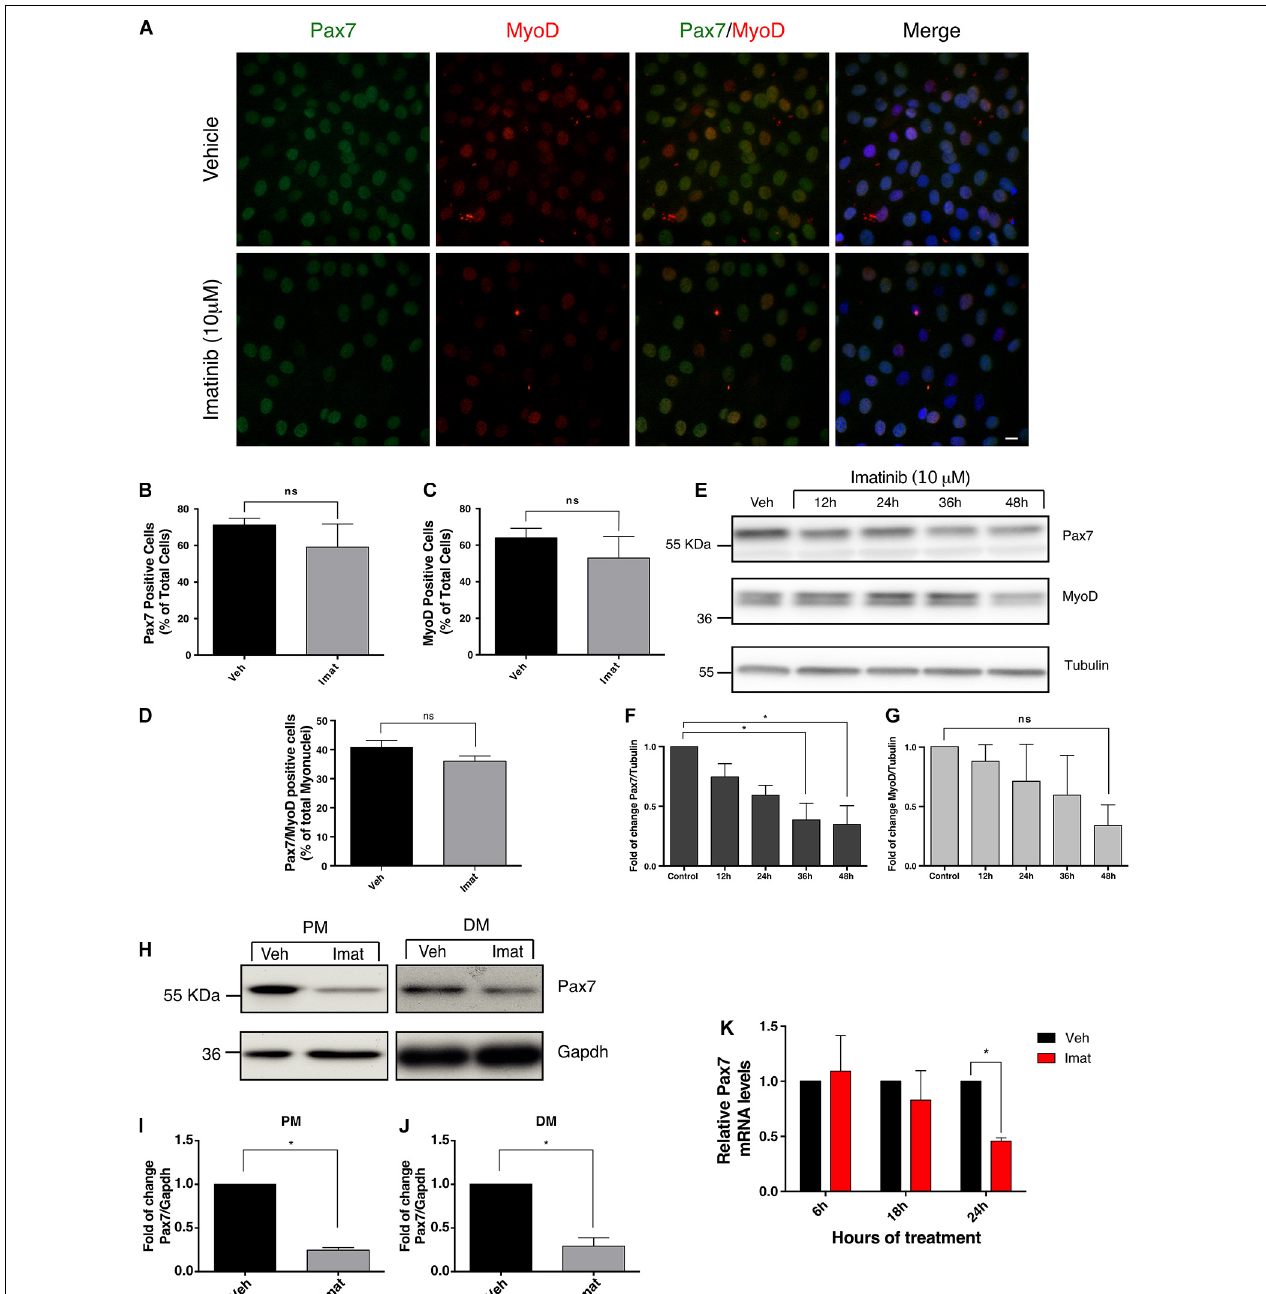
FIGURE 3 | c-Abl inhibition decreases Pax7 protein and mRNA levels. (A) Imatinib treatment does not decrease the number of Pax7 or MyoD positive cells. C2C12 cells were maintained in PM and treated with vehicle (Veh) or 10 µ M Imatinib (Imat) for 48 h. Then cells were fixed, and IF for Pax7 (green) and MyoD (red) was performed. Nuclei were stained with Hoechst 33342 (blue). Scale bar: 10 µ m. (B) Quantification of Pax7 positive cells from (A) . Veh mean: 71.11 ± 3.77%; Imat mean: 59.16 ± 12.62%. (C) Quantification of MyoD positive cells from (A) . Veh mean: 64.05 ± 5.16; Imat mean: 52.97 ± 11.70%. (D) Quantification of Pax7/MyoD double positive cells from (A) . Veh mean: 40.79 ± 2.38%; Imat mean: 36.06 ± 1.75% ( n = 4, P -value > 0.05, Mann–Whitney test, ns, not significant). (E) Imatinib induces a time-dependent drop of Pax7 protein. C2C12 cells were maintained in PM as specified and treated with 10 µ M Imatinib every 24 h. Cells were lysed, and WB was performed to determine levels of Pax7 and MyoD. Tubulin was used to normalize protein levels. Plots (F,G) show Pax7 and MyoD fold of change from (E) respectively ( n = 3, * P -value < 0.05, ANOVA test, ns: not significant). (H) c-Abl inhibition downregulates Pax7 protein levels in C2C12 cells. Cells were maintained in PM or DM for 48 h in the presence of vehicle or Imatinib (10 µ M). Then cells were lysed, and WB against Pax7 was performed. Gapdh was used to normalize protein levels. Plots (I,J) show a significant decrease in Pax7 protein levels in cells treated with Imatinib versus vehicle ( n = 4, * P -value < 0.05, Wilcoxon signed-rank test). (K) Pax7 mRNA levels decrease upon c-Abl inhibition. C2C12 cells in PM were treated with vehicle or Imatinib (10 µ M) as indicated. A significant drop in Pax7 mRNA levels is observed at 24 h in Imatinib treated cells. Veh mean: 1.0 ± 0.0; Imat mean: 0.457 ± 0.03 ( n = 3, * P -value < 0.05, multiple t